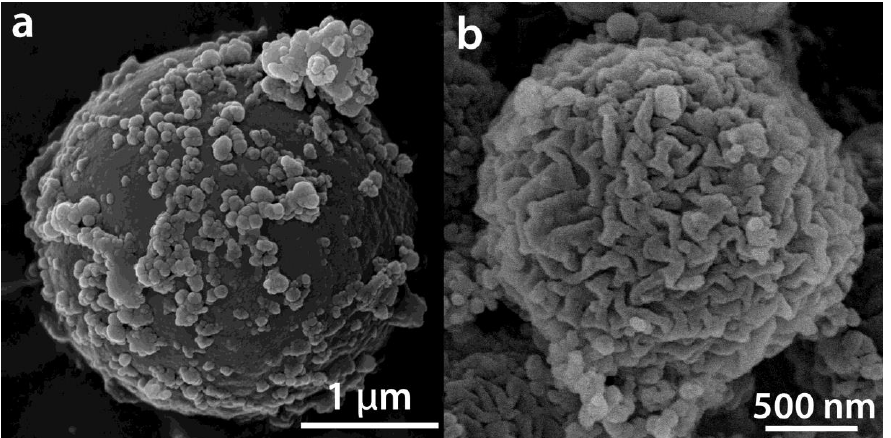
Figure 4. FEG-SEM pictures of the template + TiCl 4 and TbCl 3 mixture + HCl aq after 5 h of reaction ( a ) (it corresponds to the sample of IR in Figure 1c) and FEG-SEM picture of the 0.12 at.% Tb HSs after 7 h of reaction and calcination at 550 °C (0.12%_550) ( b ).